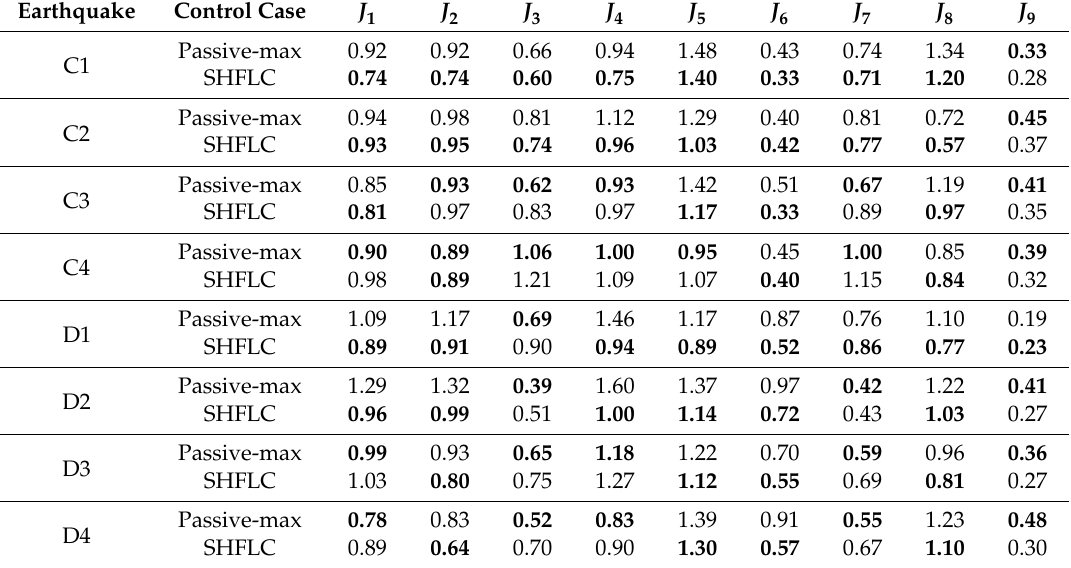
Table 8. Performance indices for various control cases under earthquakes without pulse-effect.